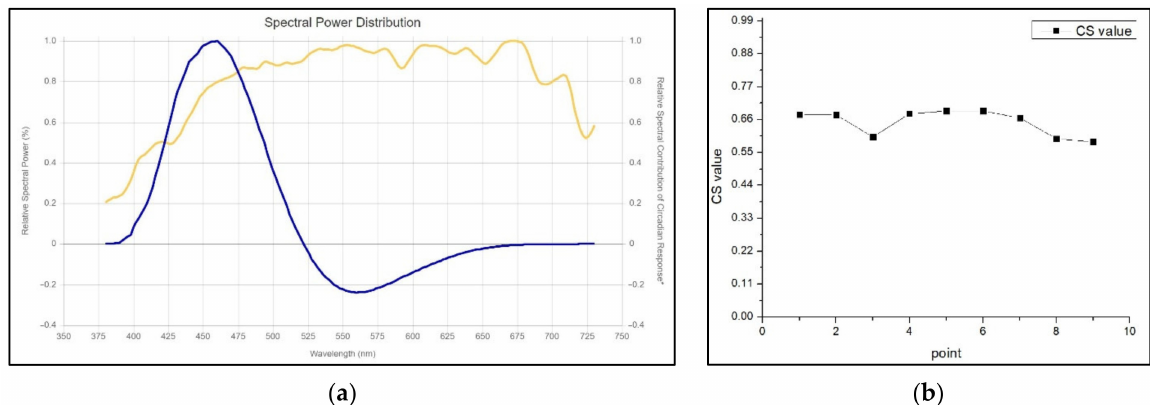
Figure 25. ( a ) Circadian stimulus (CS) value corresponding to the wavelength (the yellow curve is the spectrum under the test environment, and the indigo curve is the corresponding light intensity of the CS); and ( b ) CS values of the nine measured points on the target